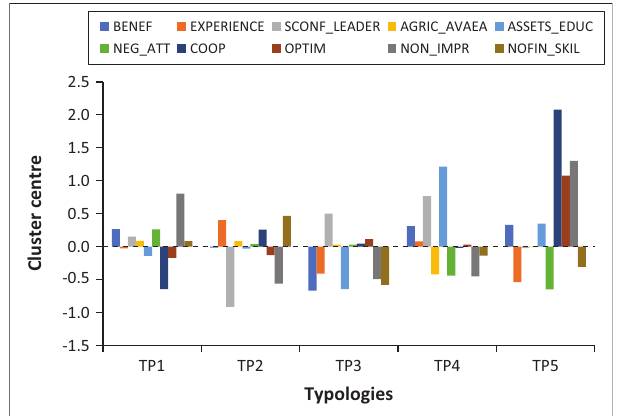
FIGURE 2: Final cluster centres from cluster analysis. TABLE 5: Youth types and level of psychological capital endowment. Psychological capital